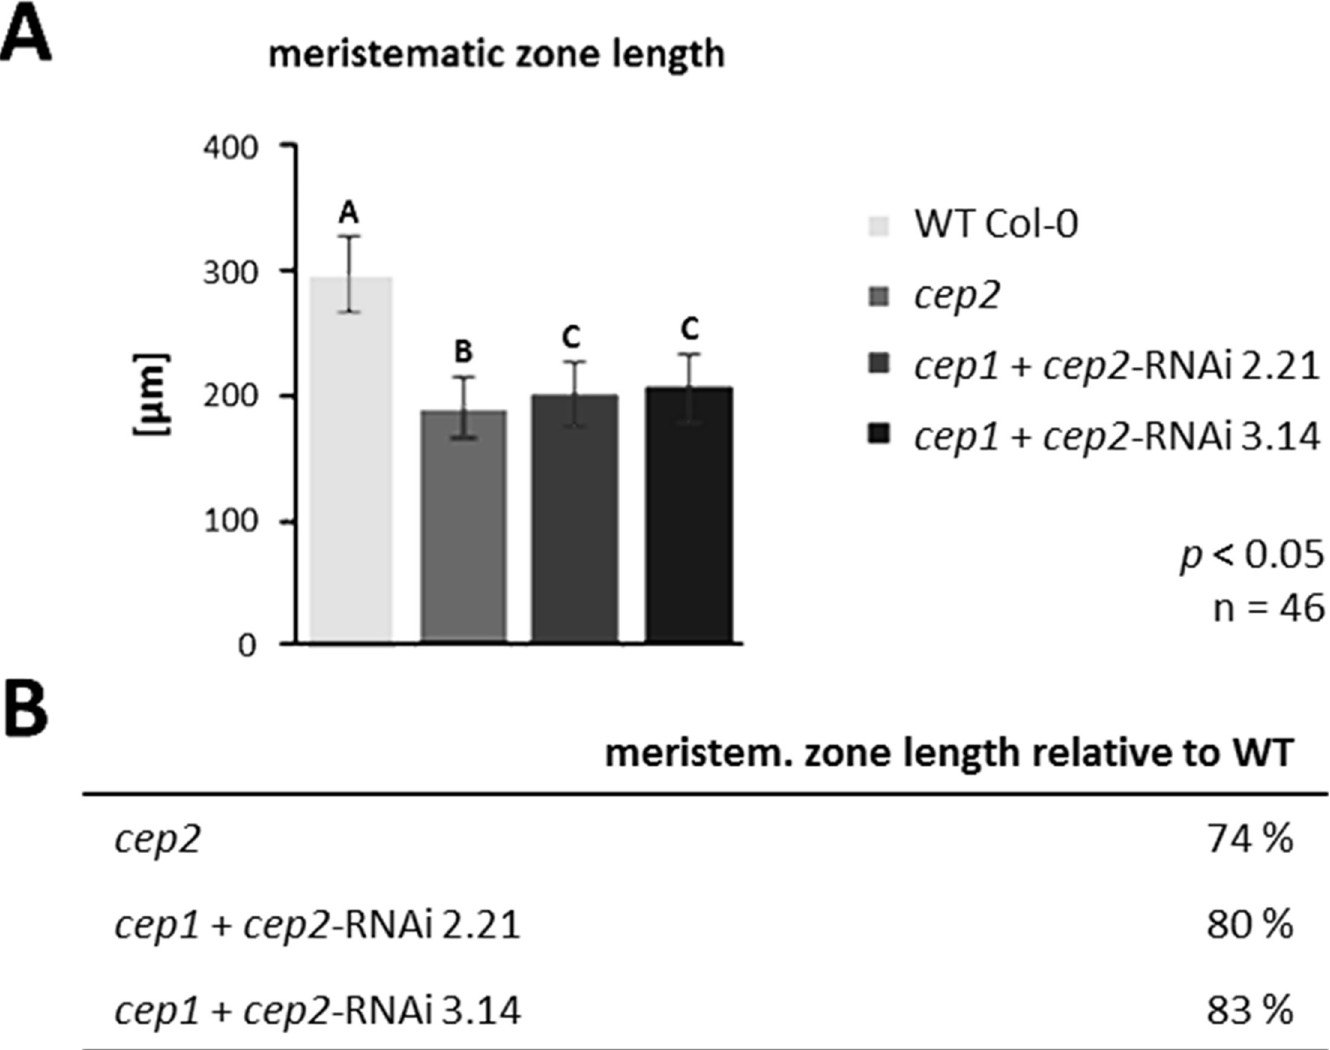
Fig 6. CEP2 loss of function results in shortening the length of the meristematic zone. The residual CEP2 activity in cep1 cep2 double ko/kd mutants ( cep1 + cep2- RNAi) results in a slightly prolonged meristematic zone as compared to cep2 ko mutant plants, but shorter as compared to WT plants. (A) Comparison of the meristematic zone length in 7 days old seedlings of WT with cep2 ko and cep1 cep2 double ko/kd mutants ( cep1 + cep2- RNAi; lines 2.21 and 3.14) mutants. Columns marked with different letters indicate statistically different groups according to the ANOVA-and Duncan test ( p < 0.05). (B) Meristematic zone length expressed as percentage of WT plants. Data represent the respective means of 46 plants in three independent experiments (biological replica) each comprising 15 plants per line (experiment 1 and 2, each) or 16 plants (experiment 3) per genotyp.